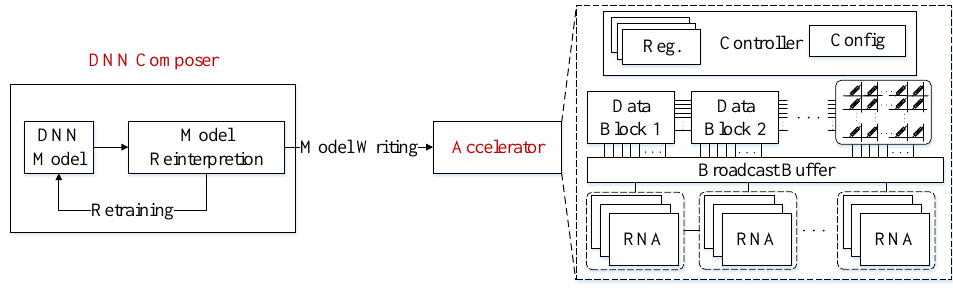
Figure 24. Overview of the RAPIDNN framework (adapted from [55]).